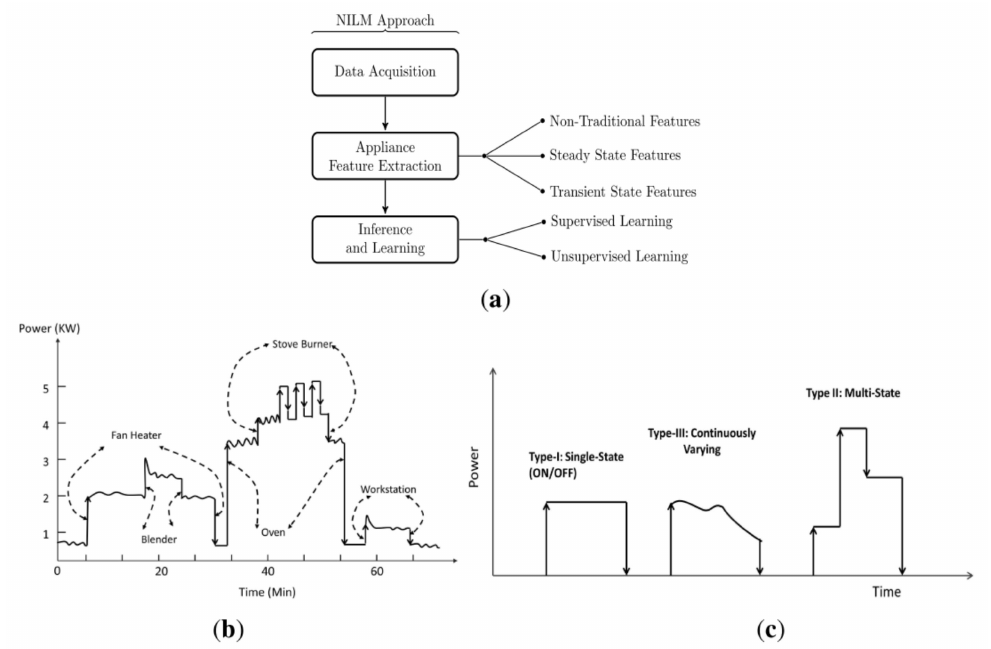
Figure 2. Classification of appliances based on their operation types [14]. ( a ) General framework of NILM approach ( b ) An aggregated load data obtained using single point of measurement; ( c ) Di ff erent load types based on their energy consumption pattern.